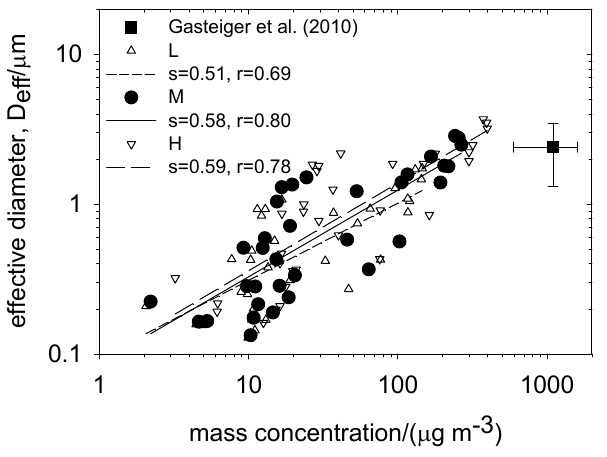
Fig. 23. Effective diameter D eff versus particle mass concentration (including Aitken mode particles; FSSP data analyzed for cases L, M, and H). The slope s and correlation coefficient r of a linear re- gression are given. Also included is the result of ground-based ob- servations for Munich, 17 April 2010 (Gasteiger et al., 2010).